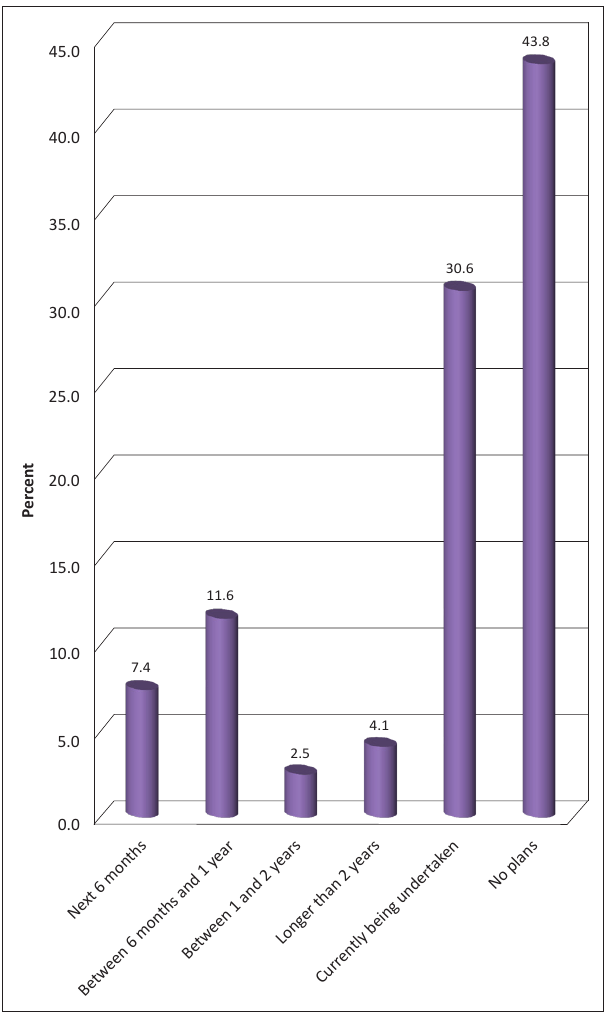
FIGURE 6: When do South African civil society organisations plan to develop a mobile